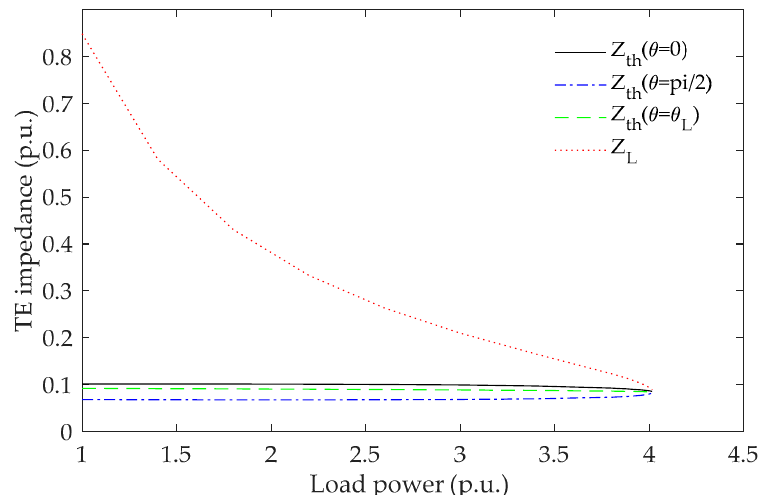
Figure 4. The calculated TE impedance magnitude of bus 3 for typical θ and loading levels.